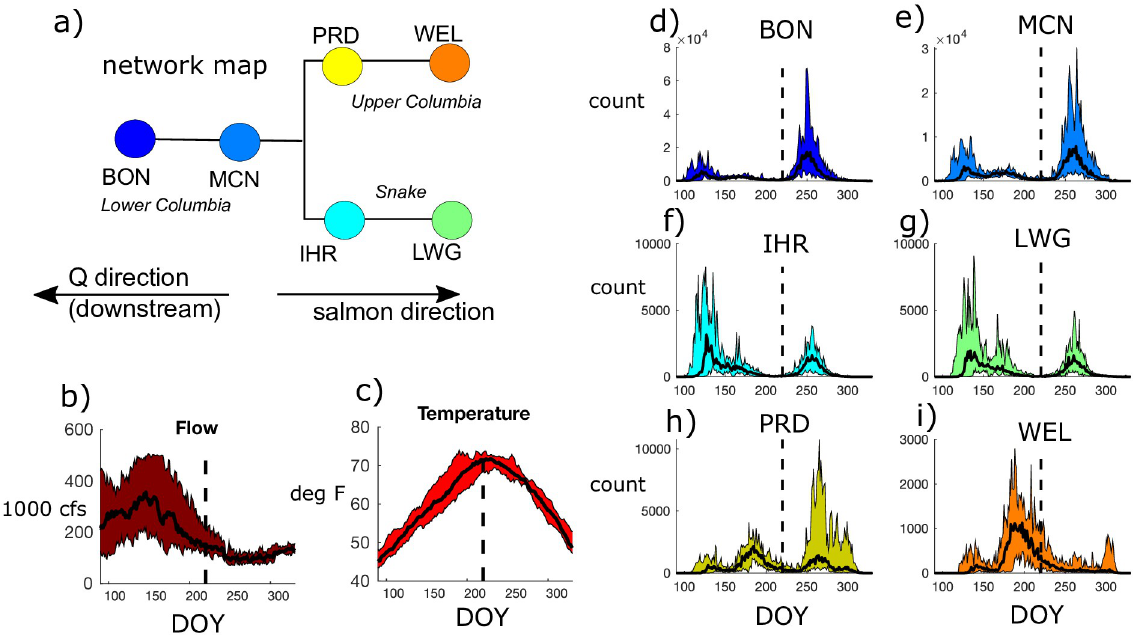
Fig 2. Distributions of salmon counts from day of year (DOY) 90 to 330 (early March through November) for 2009-2018. (a) An illustration of the network map of dams on the Lower Columbia, Upper Columbia, and Snake Rivers, where downstream flow rate is from right to left, while salmon migration is in the opposite direction. (b-i) Colored shading indicates minimum and maximum (b) flow rates and (c) temperatures at the Lower Columbia gage site, and (d-i) salmon counts for a given day. Solid black lines indicates the median values over the 10-year study period. The dotted vertical line in each plot separates defined spring (DOY 90-220, or March to August) and fall (DOY 221-330, or August to November) salmon runs. Note vertical axes have different ranges (e.g. maximum BON and MCN counts are higher than those at upstream